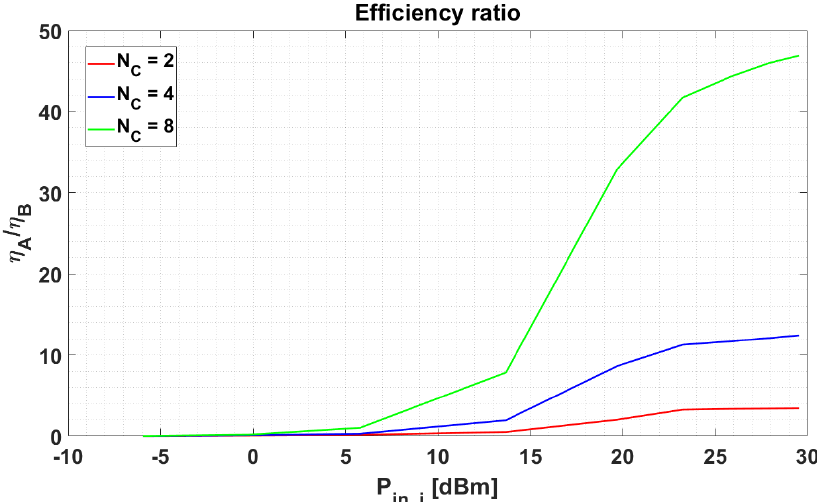
Figure 6. Efficiency ratio: comparison of Rect _ A and Rect _ B as a function of the input power level P in ß of the carrier generator and the number of carriers N c